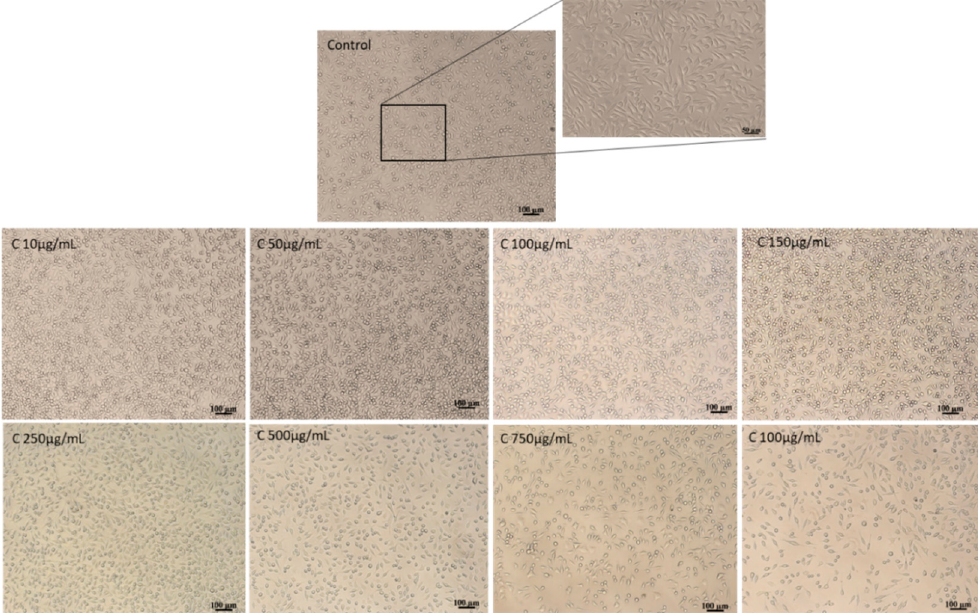
Figure 3. Light micrographs of L929 cells treated with onion extracts for 48 h.